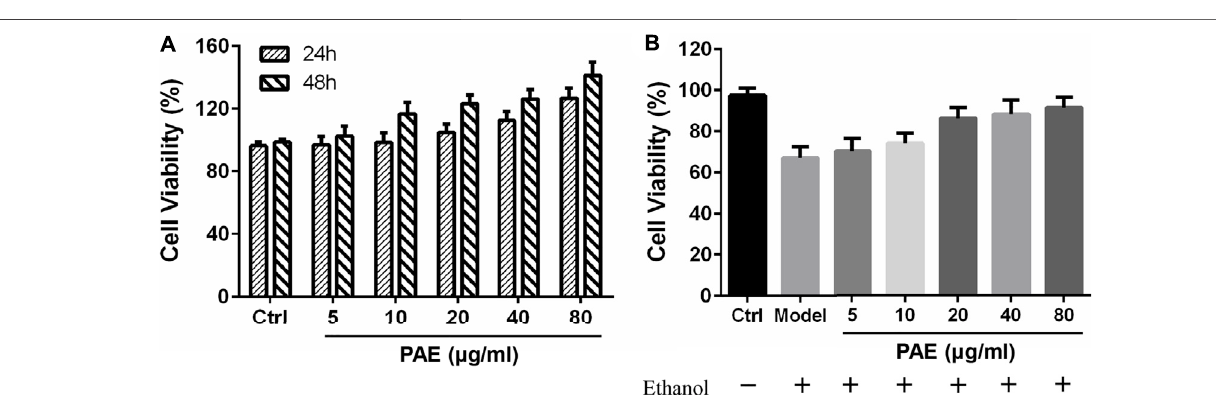
Frontiers in Pharmacology |